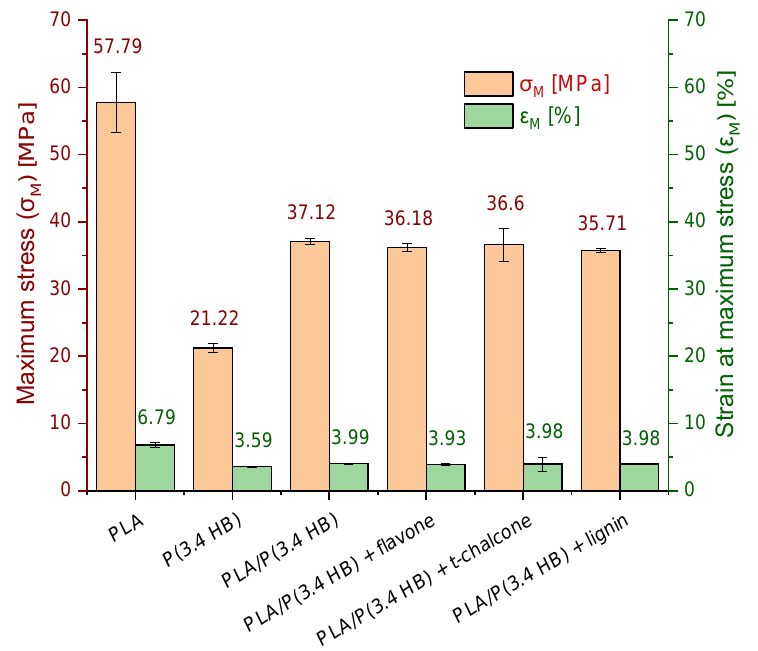
Figure 5. Maximum stress ( σ M ) (MPa) and strain at maximum stress ( ε M ) (%) results of PLA / P(3.4 HB) composites with selected natural antioxidants in comparison to reference PLA, P(3.4 HB) and PLA / P(3.4 HB) samples.